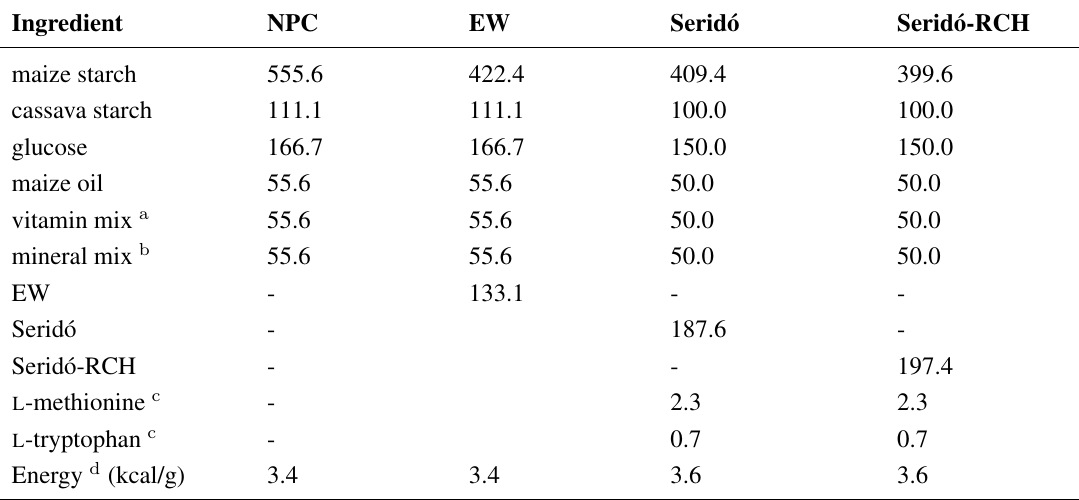
Table 1. Composition (g/kg) of non-protein control (NPC), egg white (EW) and experimental